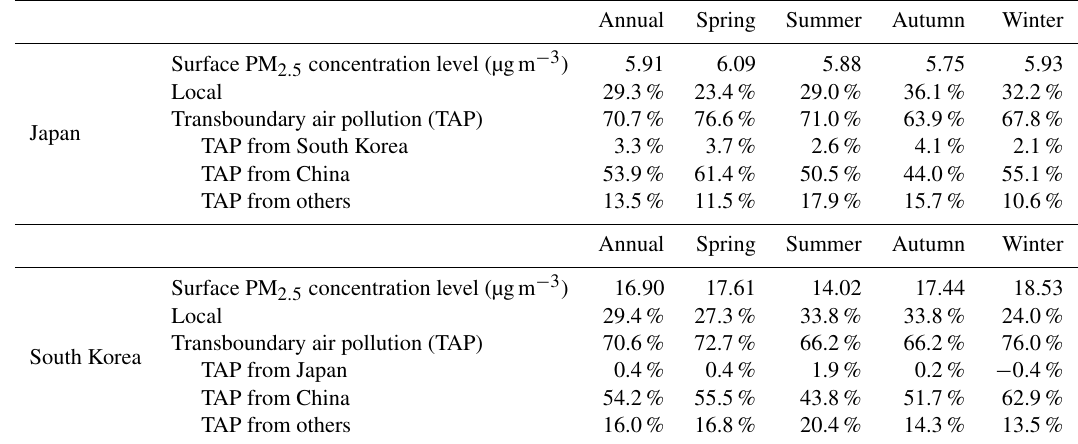
Table 5. Annual and seasonal surface PM 2 . 5 concentration levels (µgm − 3 ) and source countries’ contributions to PM 2 . 5 (%) in Japan and South